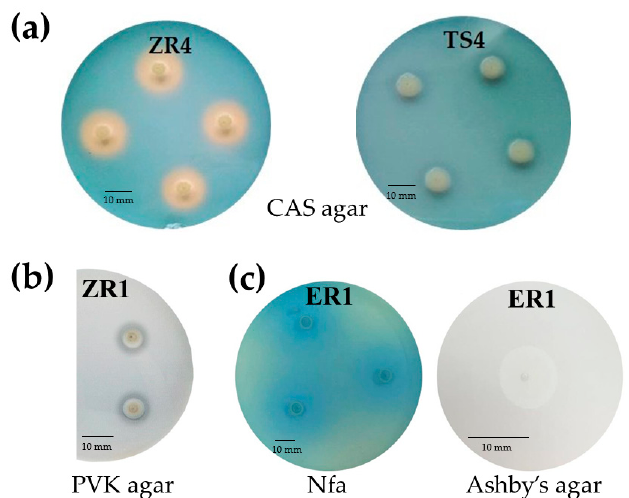
Figure 2. ( a ) The production of siderophores based on the formation of an orange zone around colonies on CAS agar after 72 h of incubation. Strain ZR4 presented positive production of siderophores, while strain TS4 show no production of siderophores. ( b ) Phosphate solubilizing by the ZR1 strain on Pikovskaya agar after 120 h of incubation. ( c ) Oligonitrotrophic bacteria ER1 on Nitrogen-free (Nfa) agar medium and Ashby’s mannitol agar (in zoom) after 72 h of incubation.